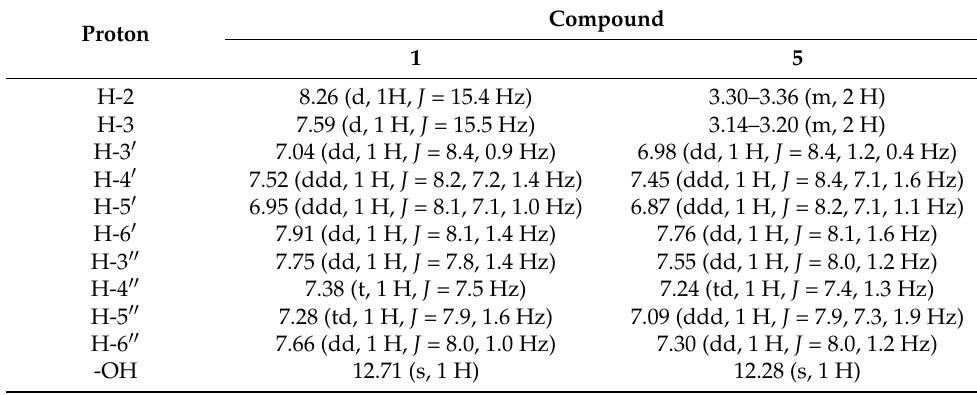
Table 3. Summary of signals visible in the 1 H NMR spectrum of the substrate ( 1 ) and the biotransfor- mation product ( 5